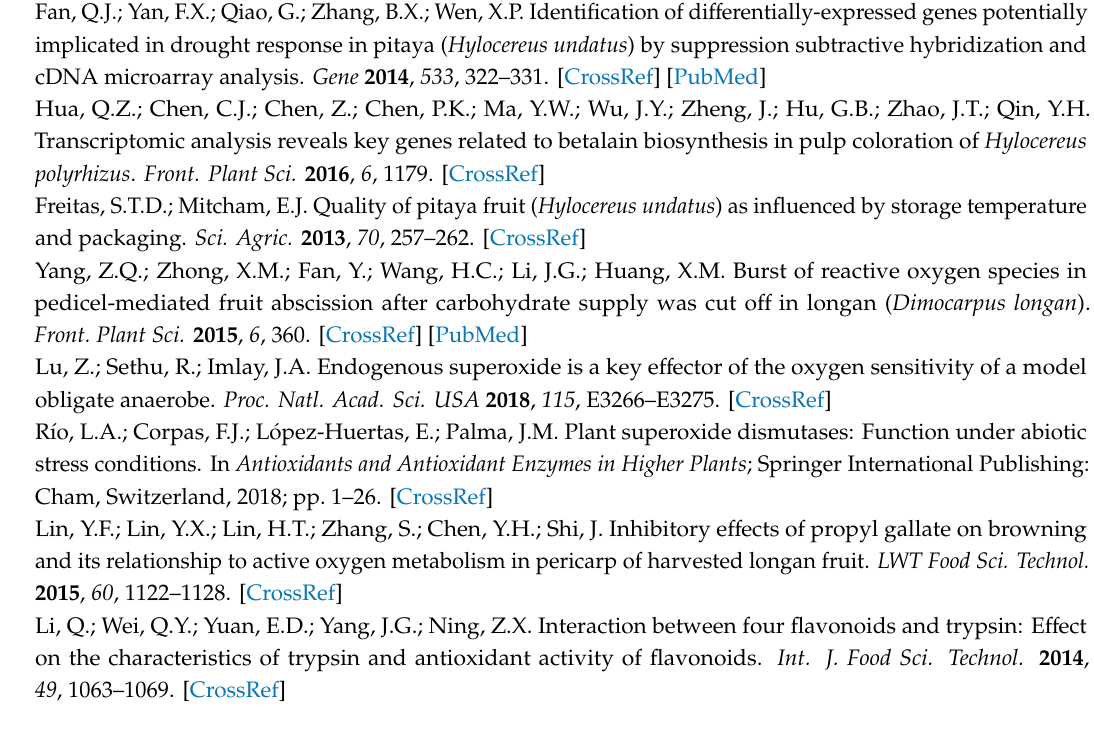
Figure S1: Sequences statistics of functional annotation of RNA-Seq data for each database. (A) Venn diagram; (B) Number of transcripts or unigenes annotated in databases; (C) Size of each list. Figure S2: Venn diagram representation of upregulated, downregulated, and all of the SOD genes identified in H. undatus . Figure S3: Bar chart of three categories of GO classification of unigenes. Figure S4: KEGG pathway of map04146. Figure S5: KEGG pathway of map03440. Figure S6: KEGG pathway of map03060. Figure S7: KEGG pathway of map03008. Figure S8: KEGG pathway of map03013. Figure S9: Relationships between GO terms of down-regulated SODs in a Directed Acyclic Graph (DAG). Figure S10: Relationships between GO terms of up-regulated SODs in a Directed Acyclic Graph (DAG). Figure S11: Histogram of KEGG terms associated with trypsin. Figure S12: Top 3 clusters of the first neighbors of SODs PPI sub-network calculated by MCODE. A-C represents cluster 1-3, respectively. SODs were colored in A. Figure S13: Power law distribution of node degree. (A and B) Degree distribution of the total ROS PPI network showed as scatter or line chart, respectively; (C) Degree distribution of the sub-network of the first neighbor of SODs; (D) Degree distribution of the sub-network of the 7 SODs. Table S1: Full list of SOD genes in each pattern after treatment with trypsin. Table S2: GO terms of SODs by trypsin. Table S3: KEGG terms associated with trypsin. Table S4: Num of unigenes in GO enrichment. Table S5: Information of 1027 unigenes related to ROS. Table S6: Information of 7 SOD unigenes. Table S7: PPI network parameters of ROS related genes by cytoscape. Table S8: Clusters of PPI network of ROS related genes by MCODE. Table S9: PPI network parameters of the first neighbors of SODs by cytoscape. Table S10: Clusters of PPI network of the first neighbors of SODs by MCODE. Table S11: Nodes in SOD sub-network ranked by 11 methods of MCC, degree, closeness, betweenness, etc. Table S12: Primer sequences used in